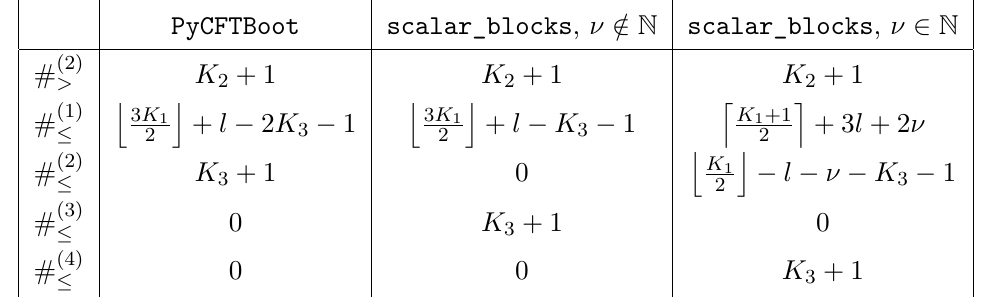
Table 1. A count of the number of poles from infinite families as a function of spin and the three cutoffs. As shown in (D.2), there is also one more pole below unitarity at b ∆ = − l − 2 K is a new simple pole for generic ν but it joins an existing pole when ν is a